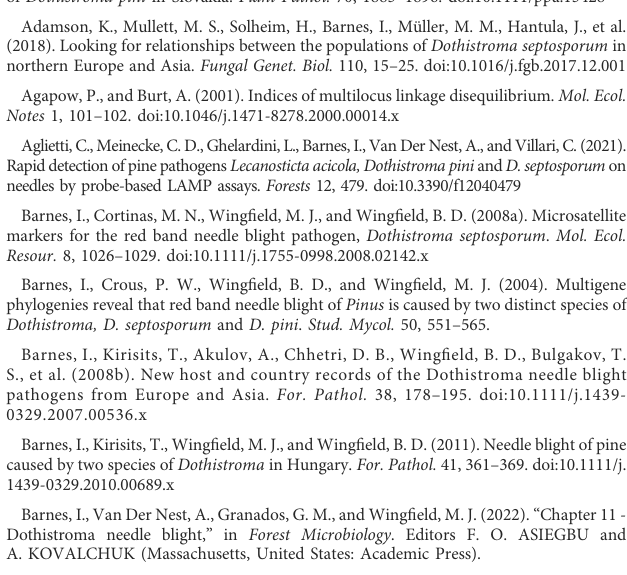
(Serbia), while individuals of MLH 32 (yellow) were detected in Ková č ová (Slovakia) and Suboti č ka Pescara (Serbia). MLH 59 (orange) was found in both Selles-Saint-Denis and La Ferté-Imbault (France) as well as in the population from Switzerland. SUPPLEMENTARY FIGURE S2 The optimum number of clusters determined using STRUCTURESELECTOR. (A) The Evanno method (Delta K and LnP (K), suggested K= 19 and K = 10 respectively. When a threshold of 0.5 was set, the Puechmaille methods (B) determined the most optimal number of clusters as 7 or 8 and at a threshold of 0.8 (C) , the most optimal number of clusters were determined to be 5 or 6. SUPPLEMENTARY FIGURE S3 STRUCTURE results of D. pini populations per country using the clone- corrected dataset. The structure bar plots show the results for the major clustering modes from K=2 to K=9. The bar plots are divided according to geographical location. SUPPLEMENTARY FIGURE S4 Haplotype network of D. pini collected in Europe drawn using Bruvo ’ s genetic distance. Each circle represents a multilocus haplotype. The larger the circle, the more individuals have the same haplotype. The circle size for 1, 22 and 47 individuals of a particular haplotype are indicated on the left hand side for scale. The same four major clusters are observed as with the STRUCTURE analysis with the Western Europe individuals (blue oval), Central European clusters (yellow and pink ovals) and Eastern European cluster (dark green) clustering together. SUPPLEMENTARY TABLE S1 Dothistroma pini collections from Europe used in this study. SUPPLEMENTARY TABLE S2 Allele sizes for 345 individuals of Dothistroma pini in Europe based on 17 microsatellite markers. SUPPLEMENTARY TABLE S3 Dothistroma pini microsatellite PCR annealing temperatures, MgCl2 adjustments, dilutions for fragment analysis for each microsatellite marker and number of alleles per microsatellite marker (Adam č íková et al., 2021). SUPPLEMENTARY TABLE S4 Summary diversity statistics of Dothistroma pini isolates within locations in